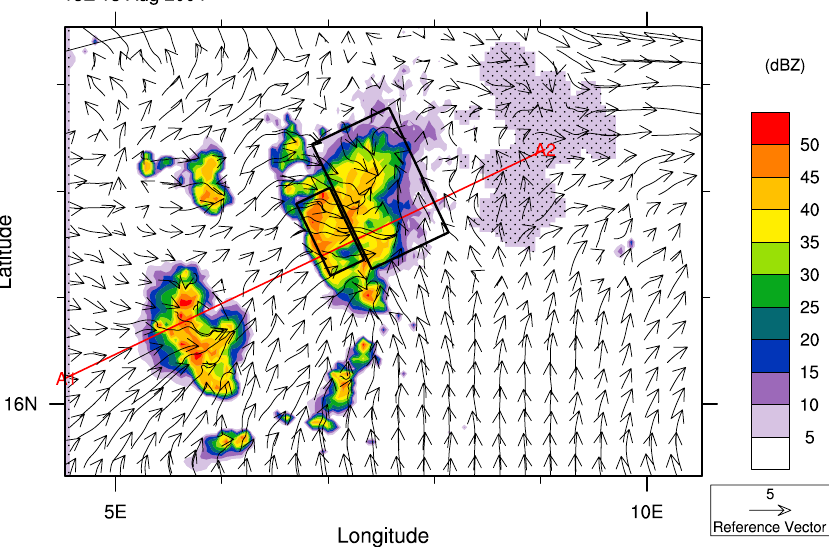
Fig. 6. Horizontal cross section of the maximum radar reflectivity (dBZ) in a grid cell column and the horizontal relative wind field at 5km altitude on 15 August 2004 at 19:00UTC simulated by Meso-NH. The black boxes delineate the convective and stratiform parts of the MCS used for budget calculations. The propagation axis is marked as a A1-A2 line. The dotted region corresponds to the A¨ır orography higher than